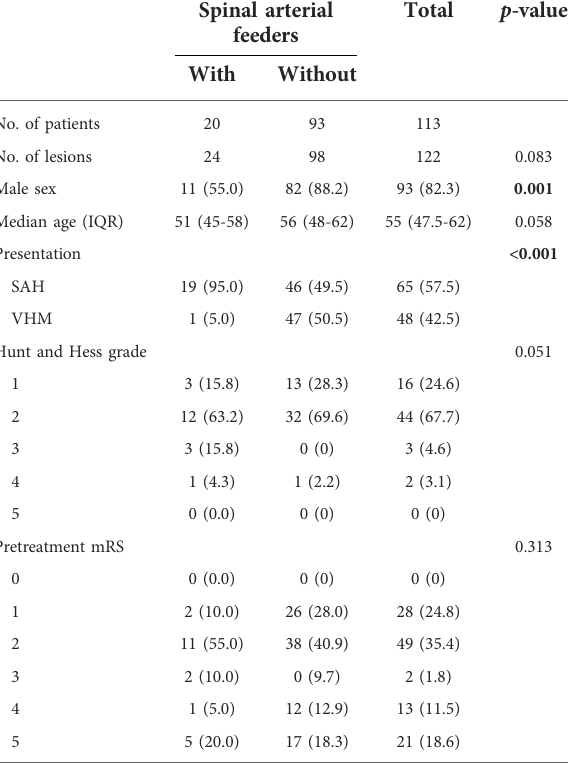
Bold text indicates statistical signi fi